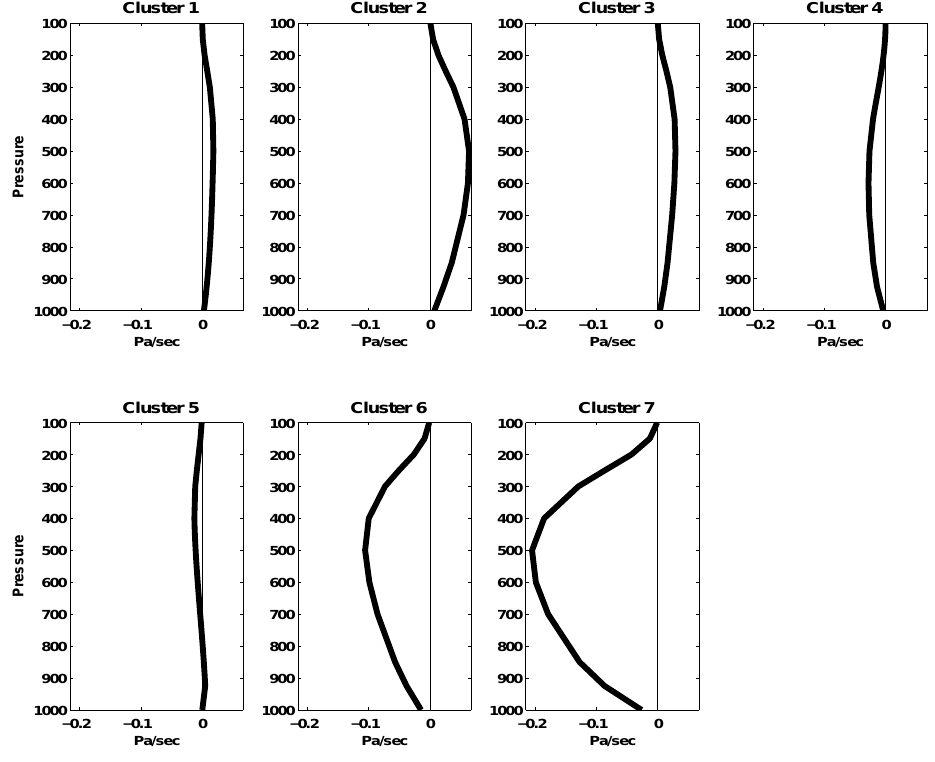
Fig. 4. As in Fig. 2, except for perturbation pressure vertical